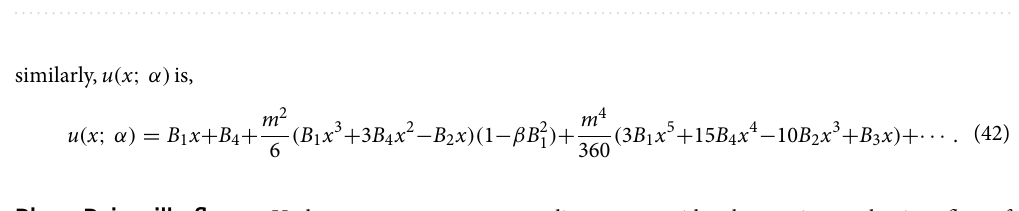
Figure 2. The geometry of the Poiseuille